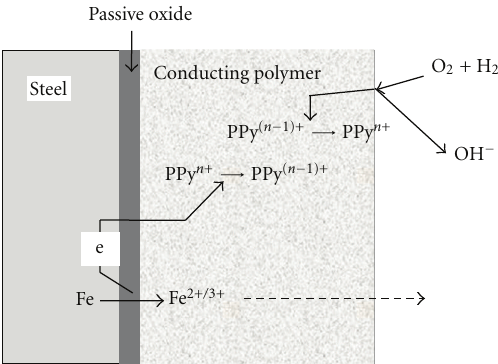
Figure 5: Degradation of oxidative property of PPy and recovery, which was done from reduction of oxygen on the PPy surface.